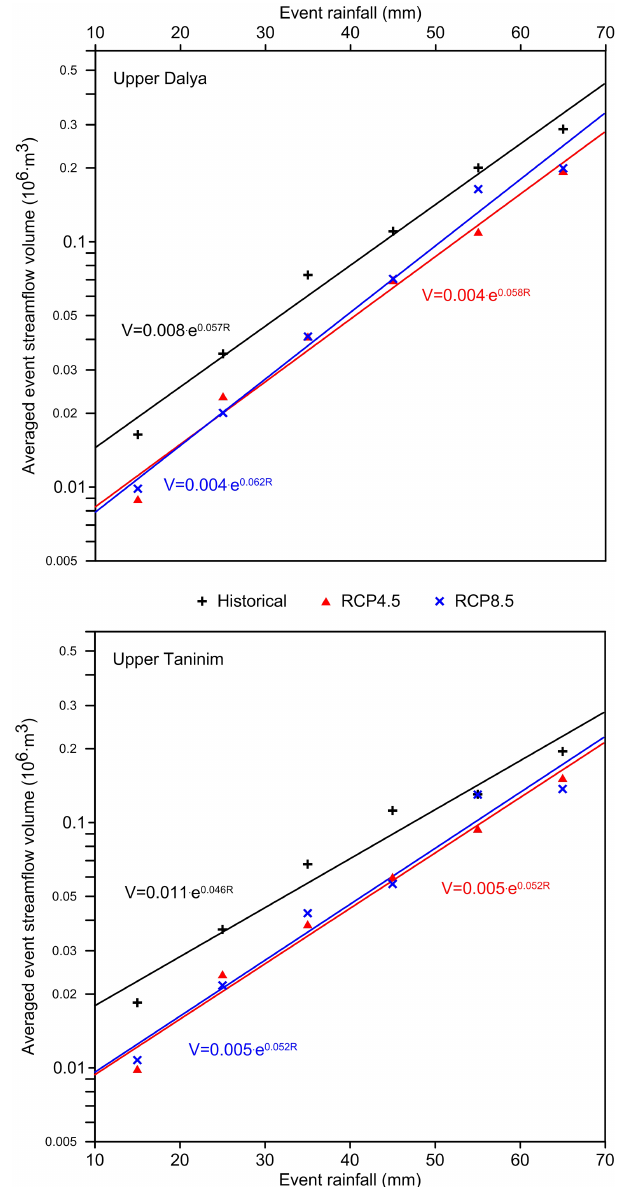
Figure 8. The average event streamflow volume vs. event rainfall depth for the historical period (black), RCP4.5 simulations (red) and RCP8.5 simulations (blue) with exponential fits (lines) for upper Dalya (upper graph) and upper Taninim (lower graph) catchments. Note that rainfall is quantized in 10mm intervals and the points in the graph represent the average of all events within each 10mm interval of